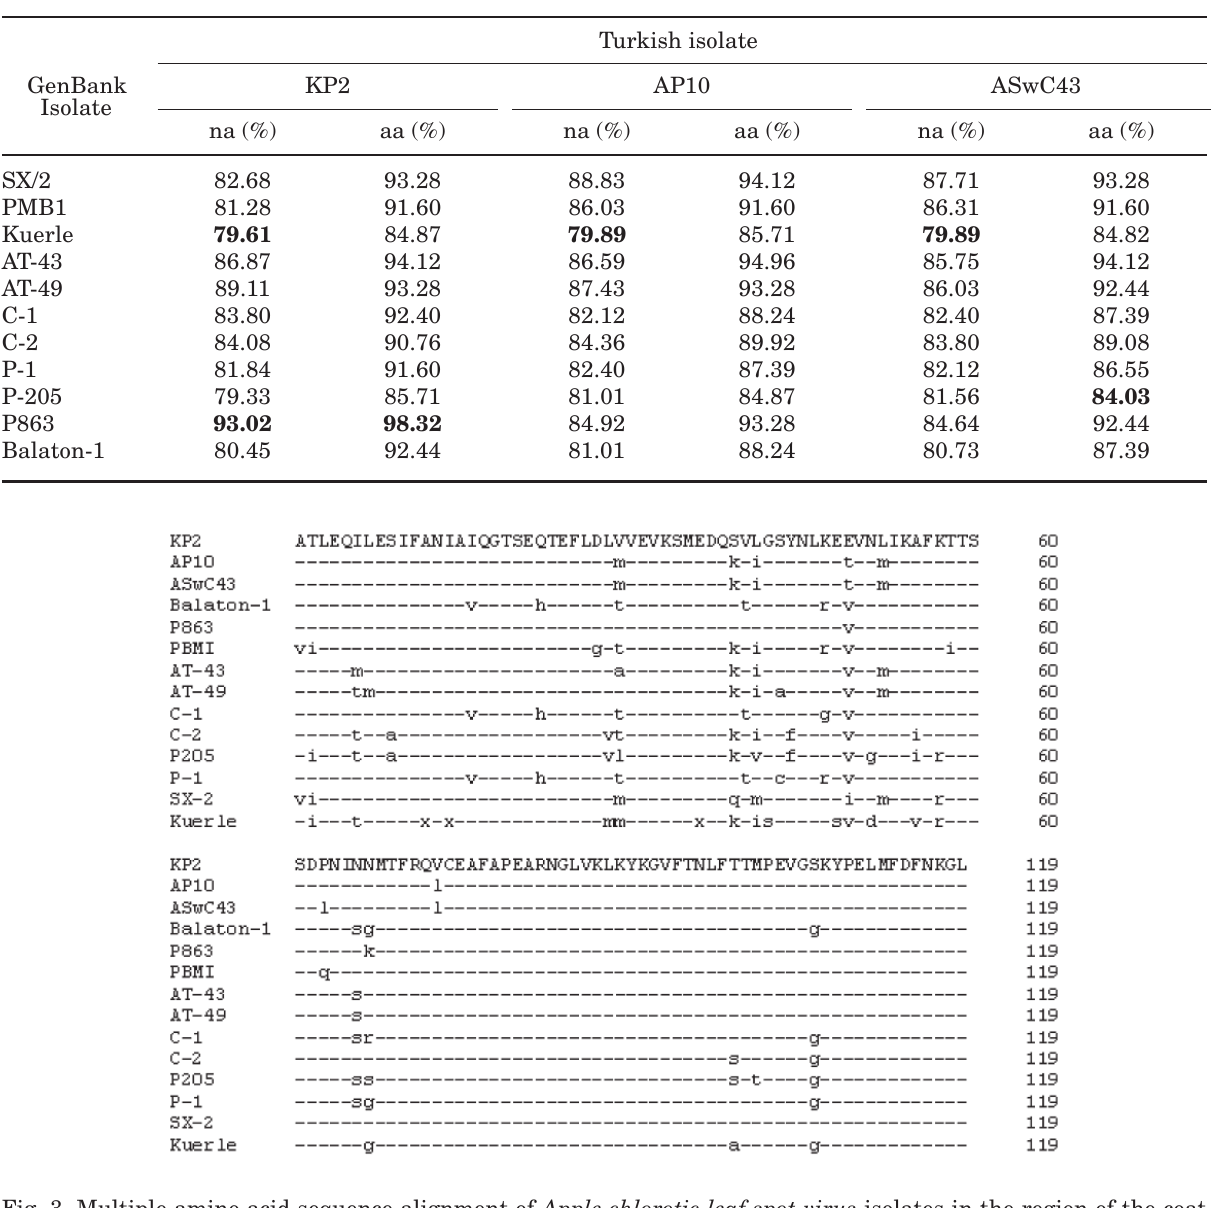
Table 3. Percentage of identity of nucleic acid (na) and amino acid (aa) sequences between pairs of Apple chlorotic leaf spot virus isolates. Identities of interest are given in bold numbers.